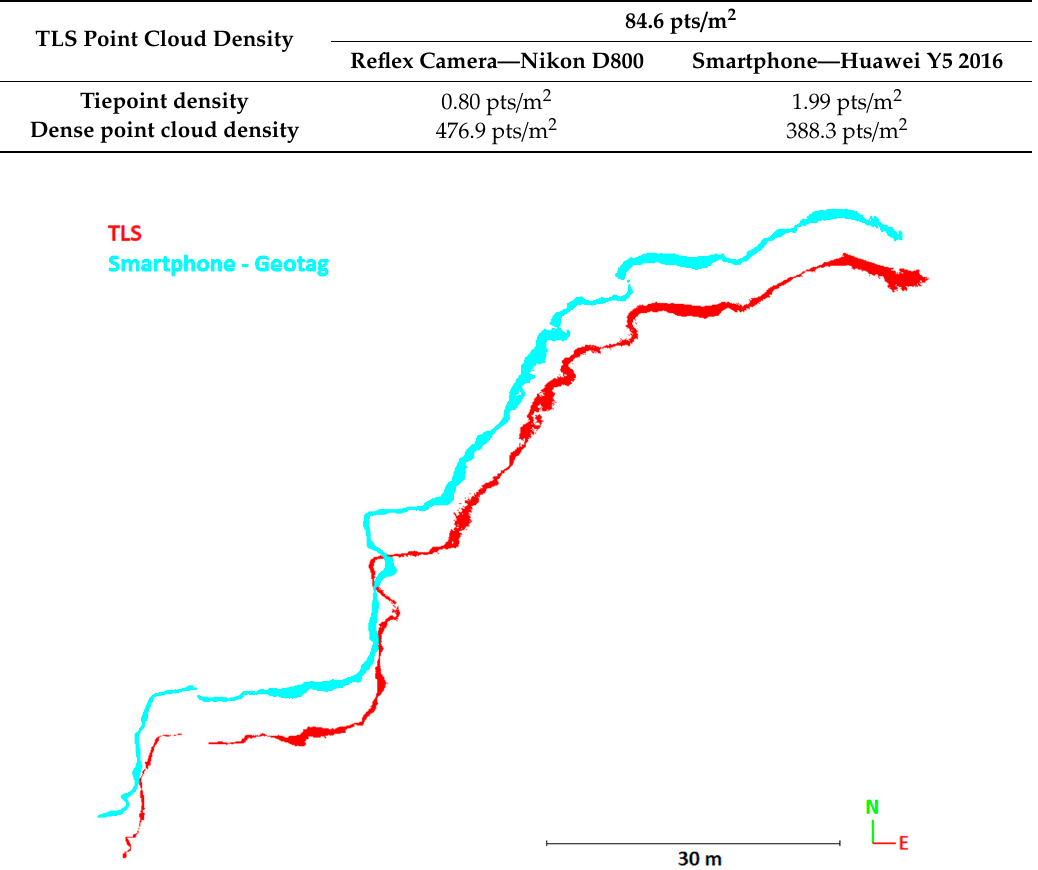
Figure 5. Comparison (in top view) of the cliff face representation by point clouds respectively measured by the Terrestrial Laser Scanner (TLS) (in red) or reconstructed by SfM photogrammetry using the Geotag of the photographs (in light blue).